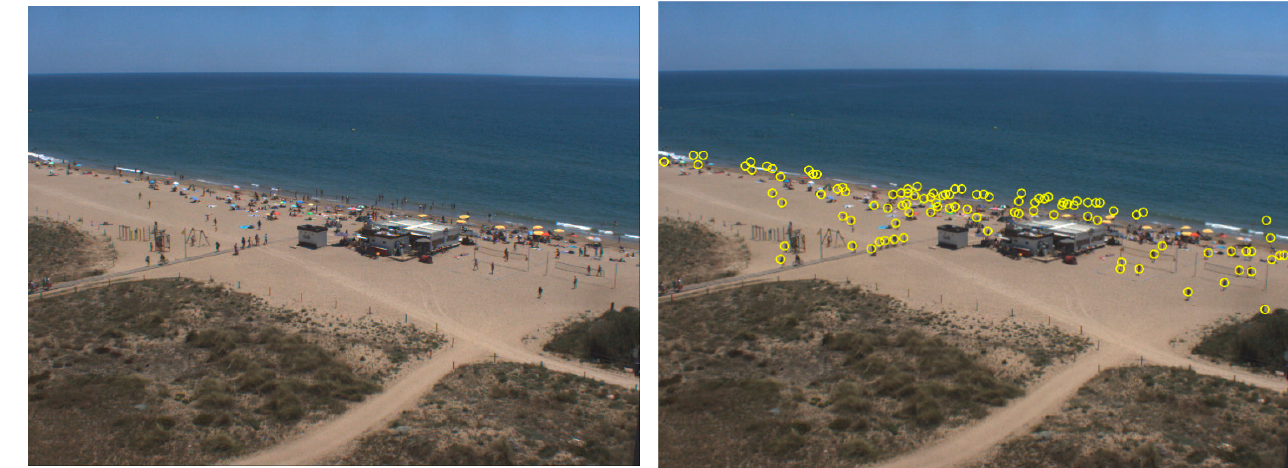
Figure 4. Camera captured image ( left ) and image result of the detection algorithm ( right ) at Castelldefels beach, 16 June 2018.